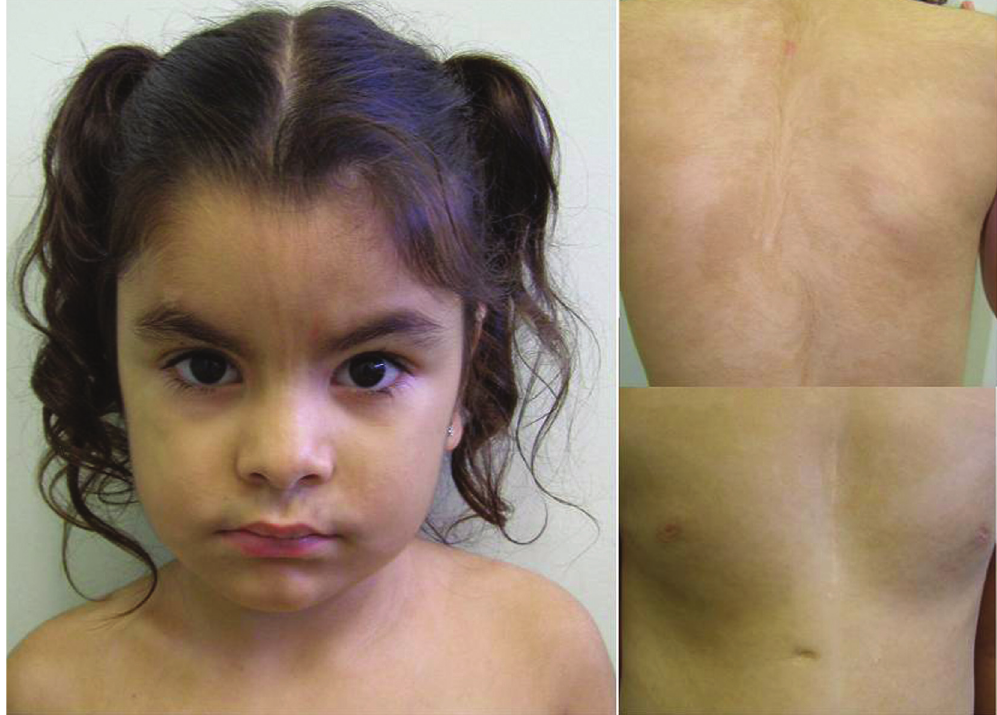
Figure1 -Facialandtrunkviewsofthepatient.Notehypertrichosisonfrontanddorsum,aswellasareasofhypoandhyperchromicpigmentationfollow- ing the Blaschko